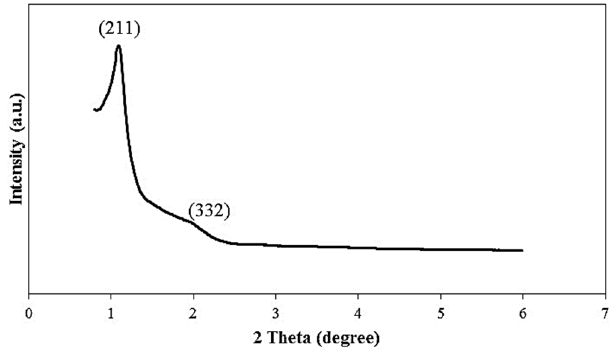
Figure 1. XRD pattern of KIT-6.